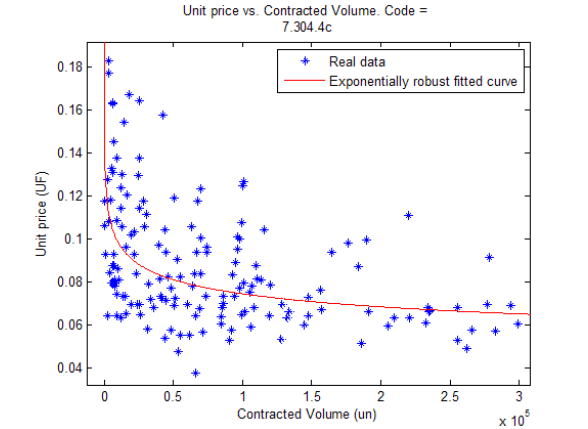
Fig. 4. 7.304.2b – cold mix manual surface patching curve fitting